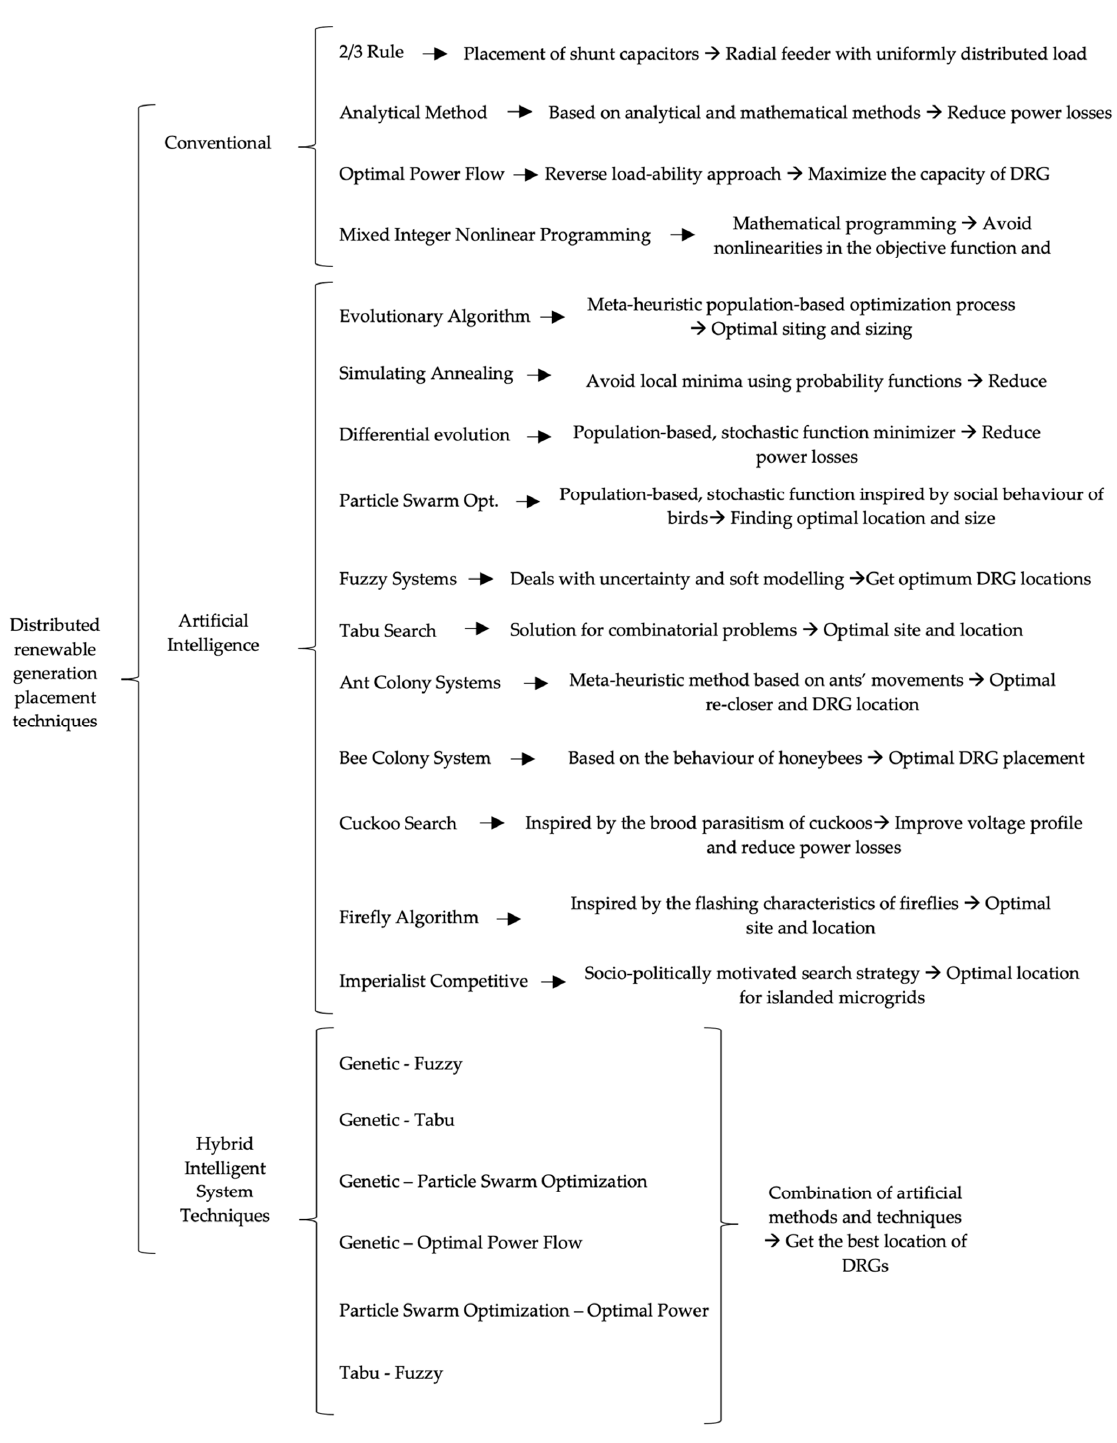
Figure 2. Optimization placement techniques for DRG. Adapted from [82].